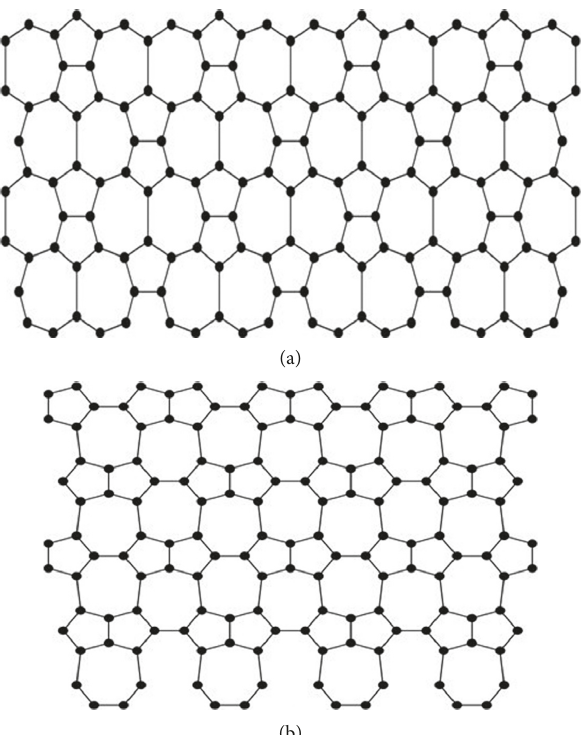
Figure 2: The nanosheets (a) VC Table 1: Partition of the edge set of VC